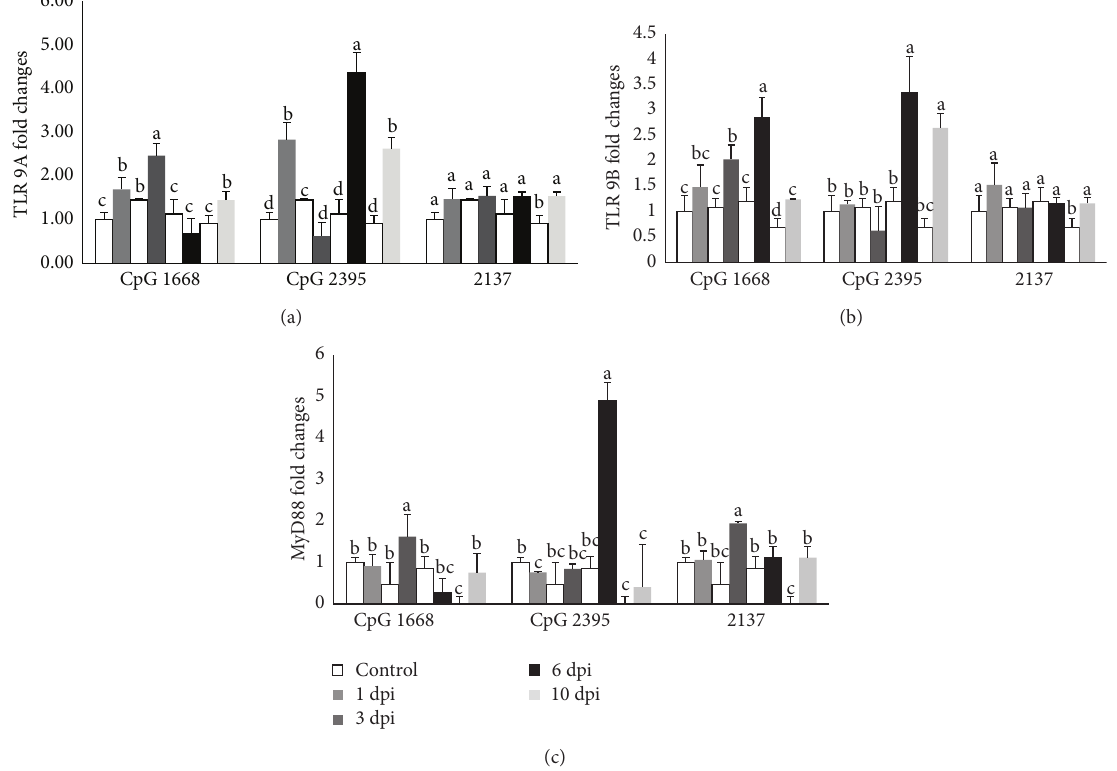
Figure 3: The relative mRNA expressions of TLR 9A (a); TLR 9B (b); and MyD88 (c) in cobia intestine after stimulating with different CpG ODNs (1668, 2395) and ODN 2137 as control measured by quantitative real-tie PCR at 1, 3, 6, and 10 days after stimulation. The expression values represented as “fold change” were compared to the noninjected control samples and 𝛽 -actin was used as a reference gene. The results are presented as the mean ± SD ( 𝑛 = 2 ) and mean values with different alphabetical letters are significantly different ( 𝑃 ≤ 0.05